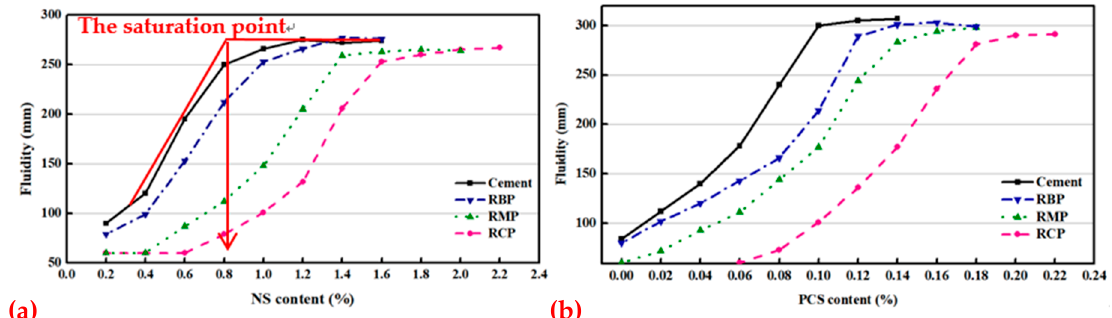
Figure 16. The saturation point of cement paste mixed with RP: ( a ) NS, ( b ) PCS.